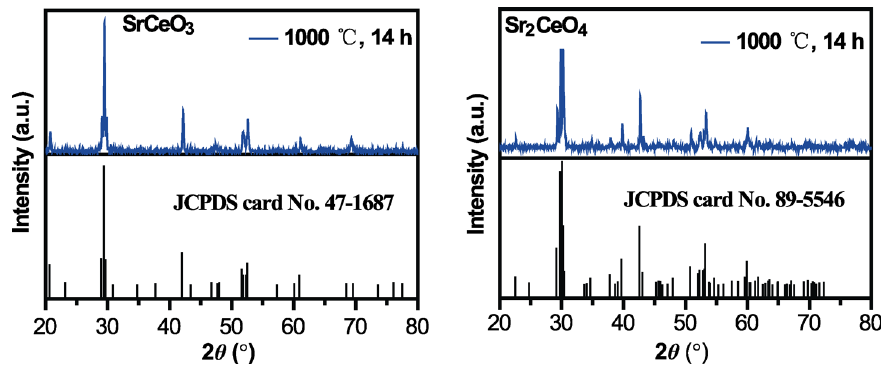
Fig. 2 XRD patterns of calcined powders.